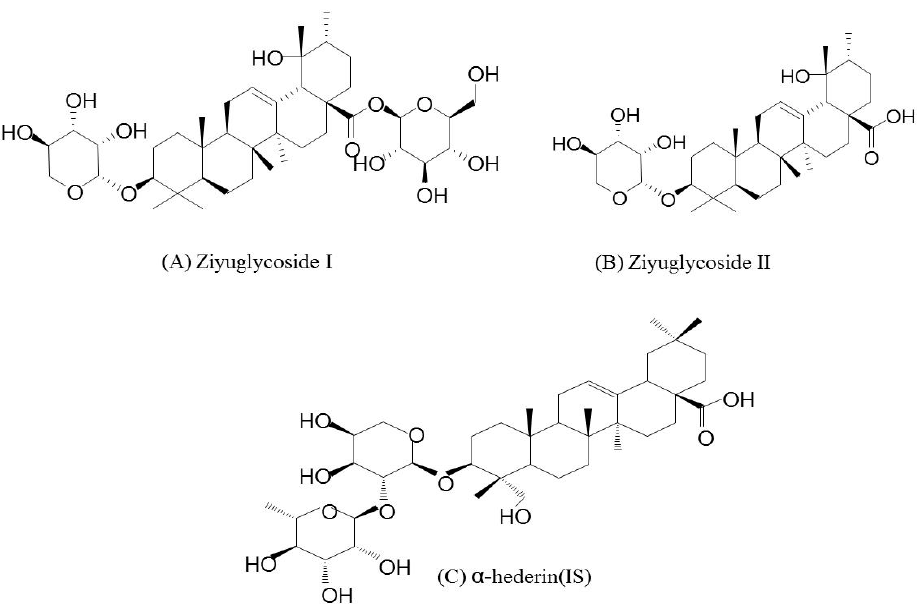
Figure 1. Chemical structures of ( A ) ZGS1; ( B ) ZGS2; and ( C ) α -hederin (internal standard).